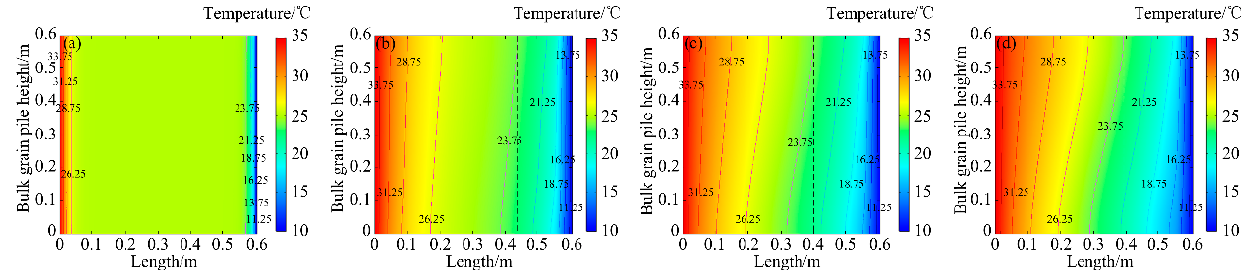
Figure 7. Temperature distribution in the middle plane of the grain pile at different time points: ( a ) 1 h; ( b ) 24 h; ( c ) 48 h; ( d ) 72 h.